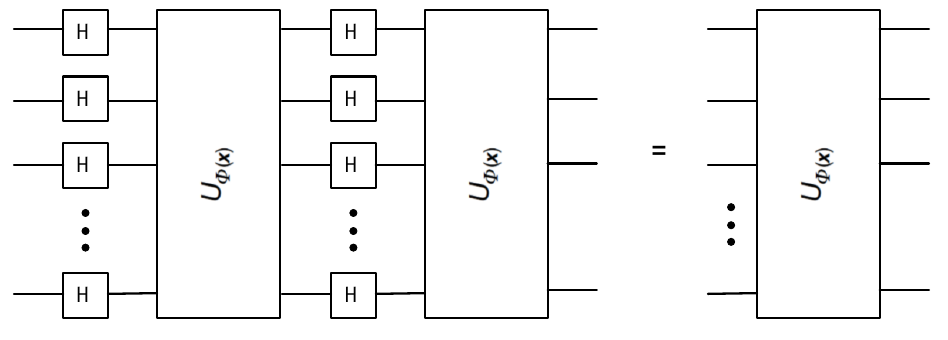
Figure 1. Circuit